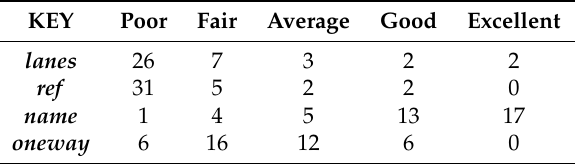
Table 8. Summary of the compliance of all cities with suggested tag key combinations for the target tag highway=tertiary